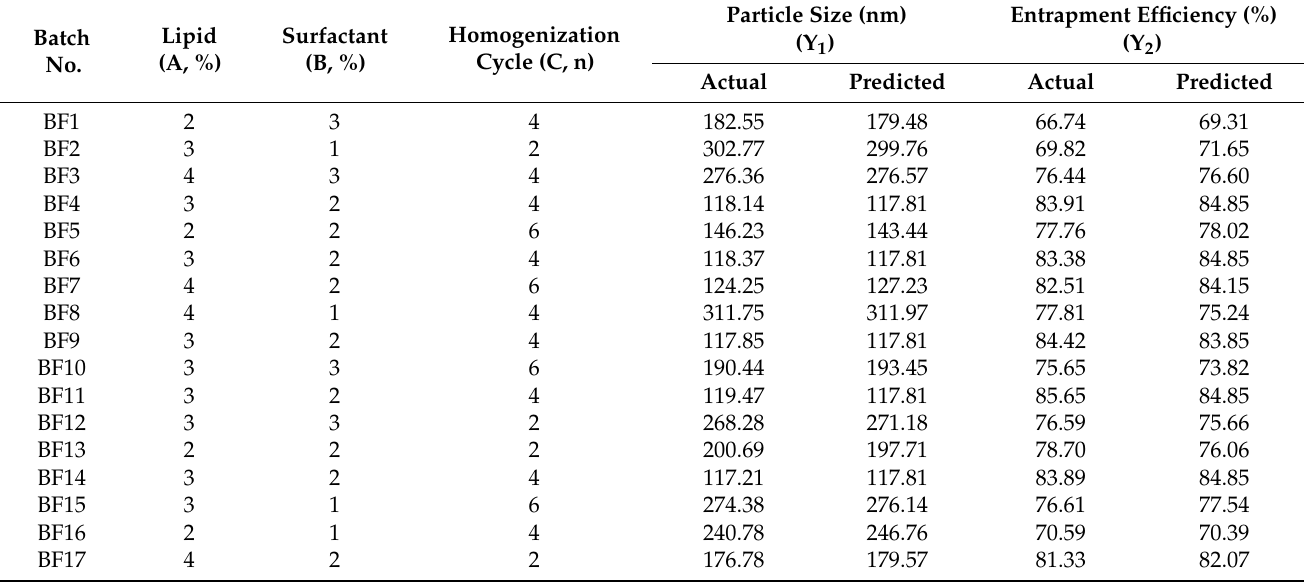
Table 2. Composition of BF-loaded NLCs with their actual and predicted particle size and encapsulation efficiency.